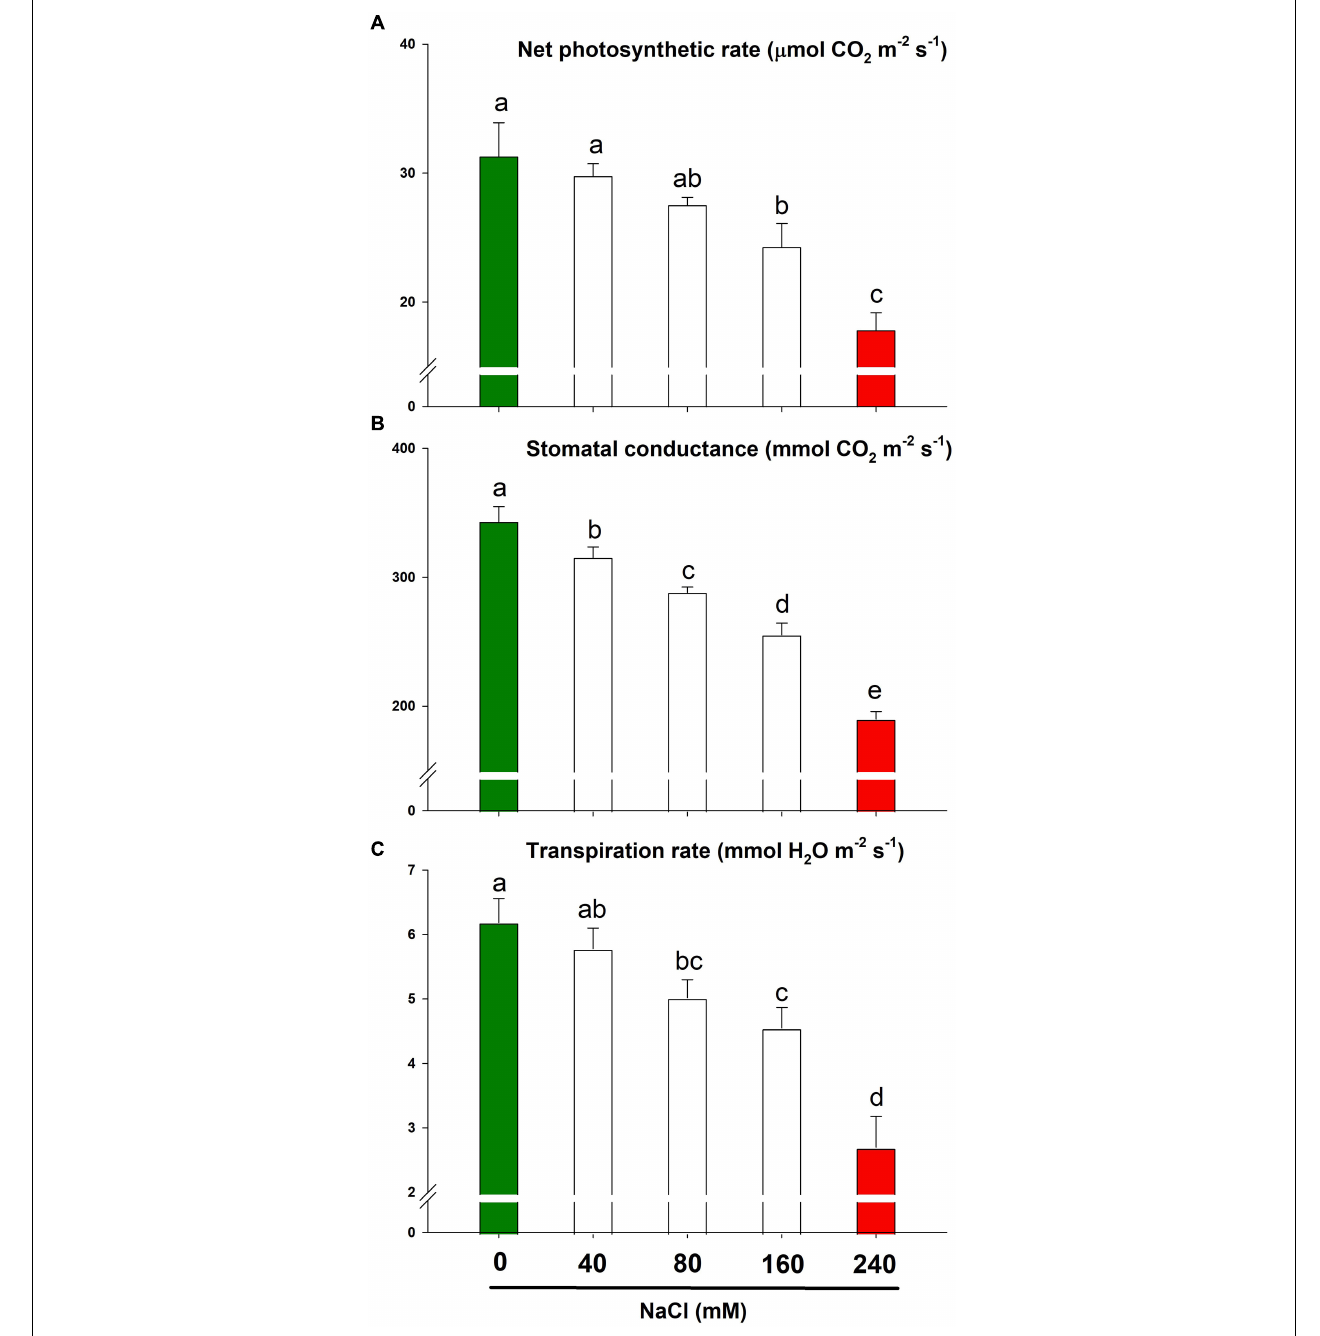
FIGURE 5 | The gas exchange response of lemongrass to NaCl concentrations (0, 40, 80, 160, and 240 mM) with the focus on net photosynthetic rate (A) , stomatal conductance (B) , and transpiration rate (C) . Each bar represents mean ± SE ( n = 3). Means followed by the same letter(s) do not differ by LSD test at 5% probability level ( α = 0.05). The colors are just visual ques for readers to quickly distinguish between control and most stressed treatment.